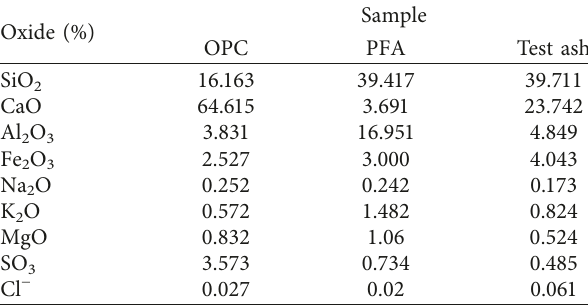
Table 1: Results of chemical analysis of the test materials